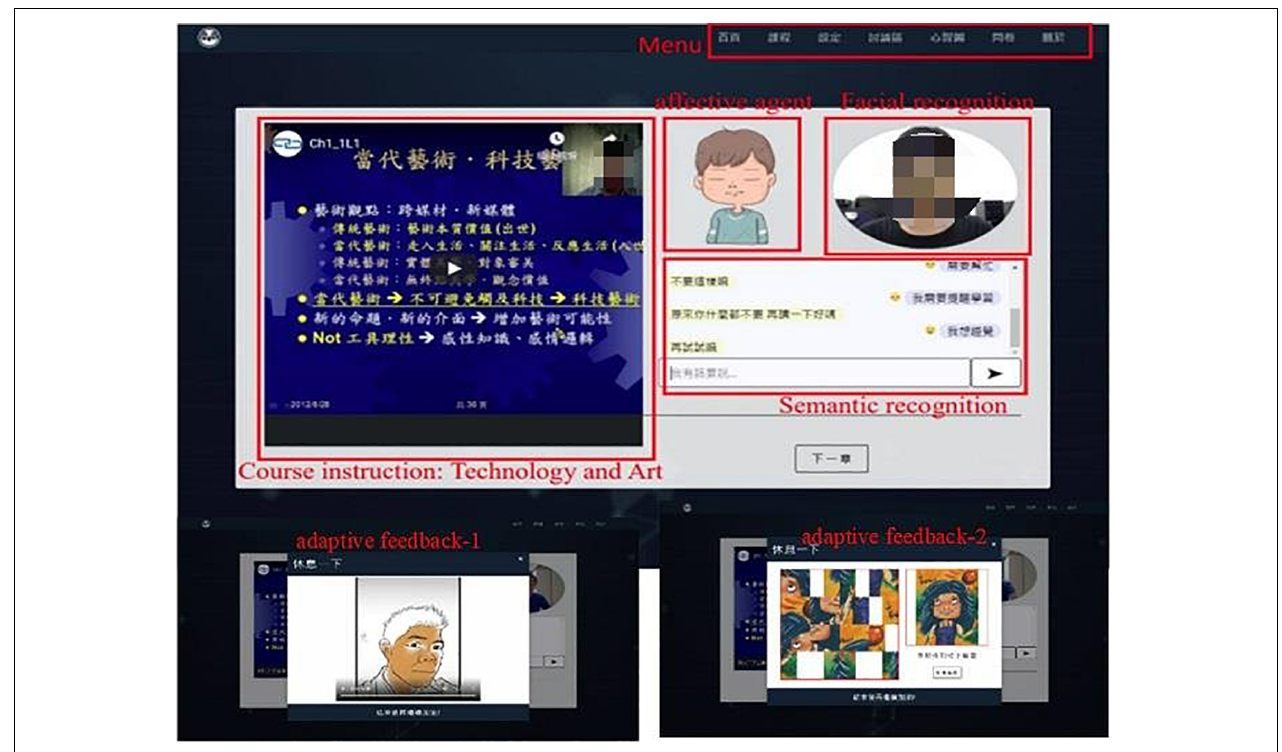
FIGURE 1 | The affective feedback adaptive learning system.